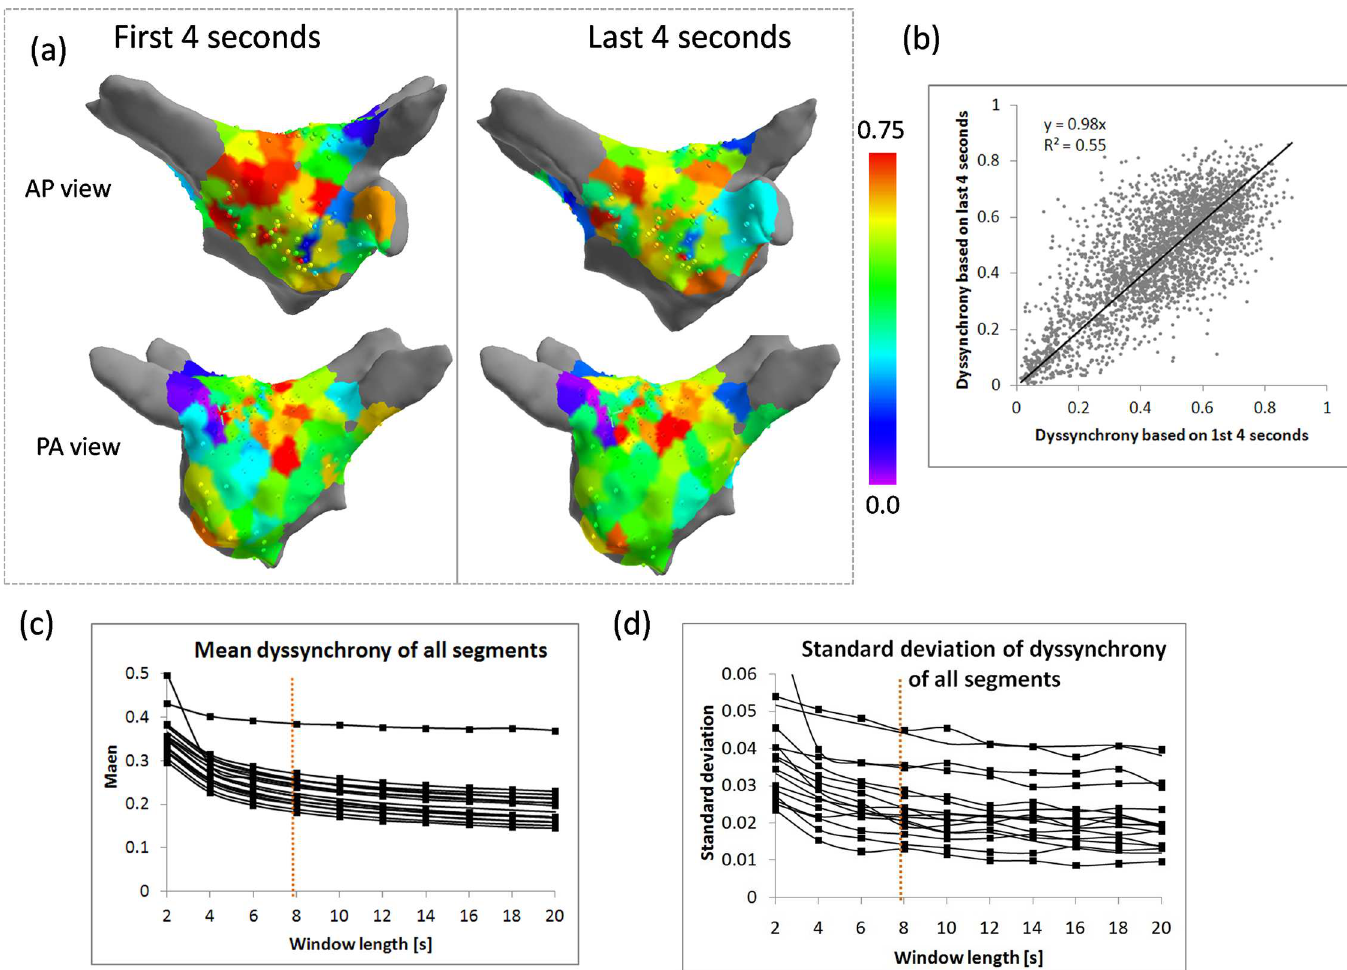
Fig 6. Temporal stability of dyssynchrony measure. (a) Example maps of local dyssynchrony in first and last 4 s of recorded segment. (b) Correlation between local dyssynchrony in first and last 4 s of recorded segment (all data points). (c) The dependency of mean (c) and standard deviation(d) of dyssynchrony for different lengths of the electrogram used in the